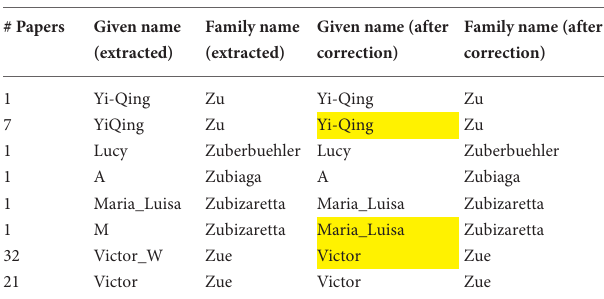
FIGURE 8 | Example of cleaning authors’ given names and family names. Values colored in yellow indicate manual corrections.